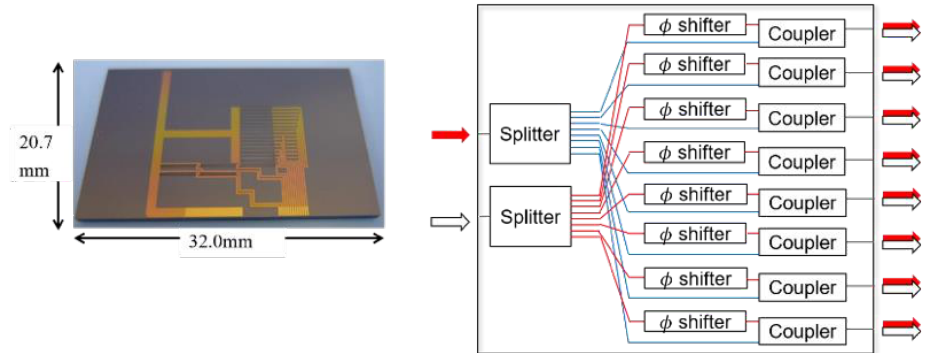
Figure 8. Integrated phase controller consisting of a silica-based planar lightwave circuit; photograph ( left ) and schematic configuration ( right ).